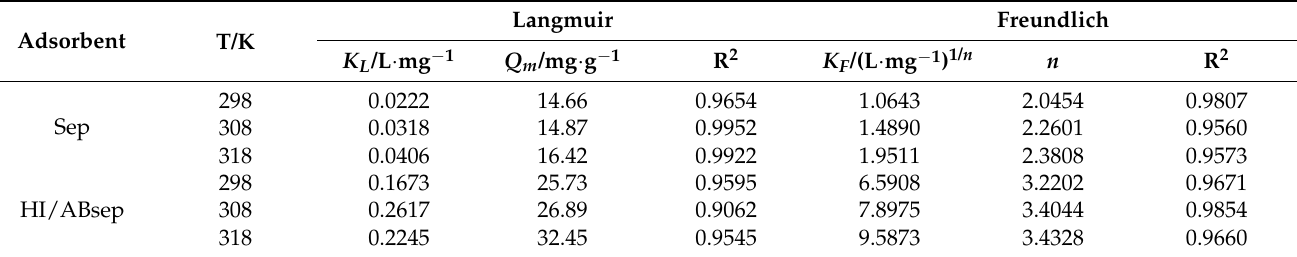
Table 3. Comparison of Sb (III) adsorption by various